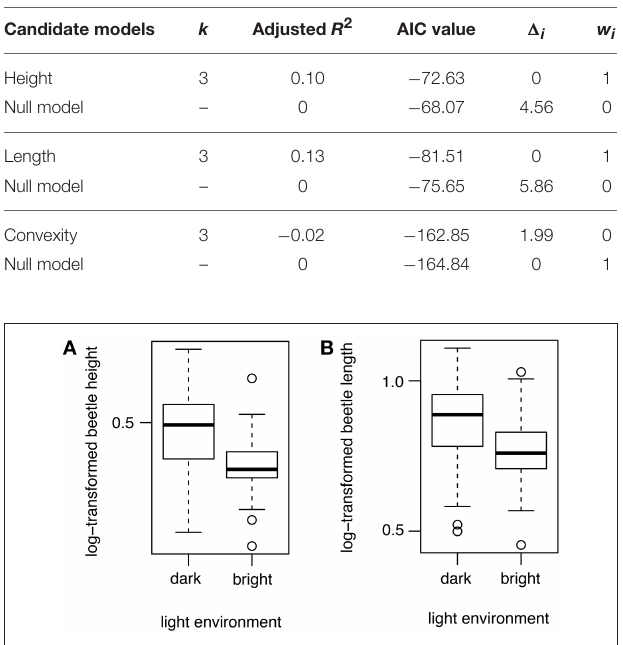
FIGURE 5 | Boxplots illustrating the effect of light environment on beetle morphology. The x-axes represent the light environments as dark or bright. Beetles with greater length (A) and height (B) tend to be in dark environments instead of bright environments.